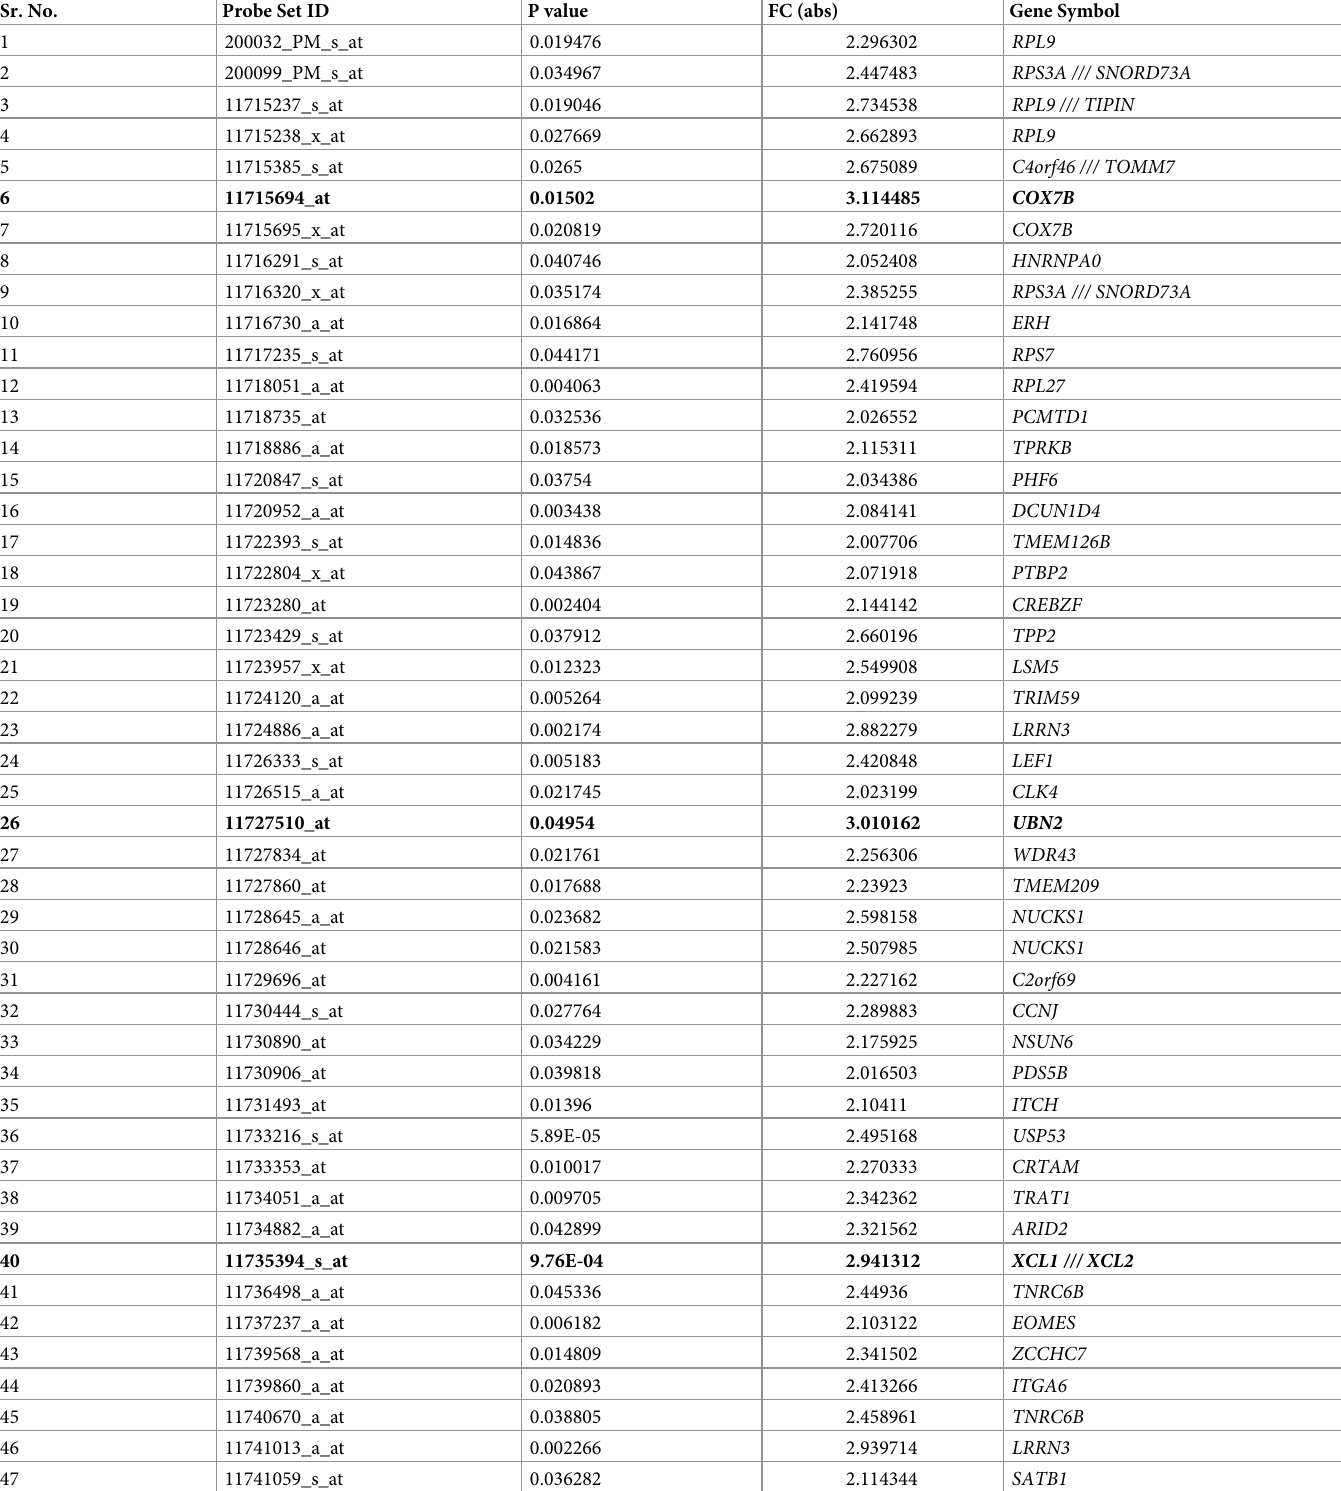
Table 3. Summary of genes differentially down-regulated in ART-IF as compared to ART-R. Sr.